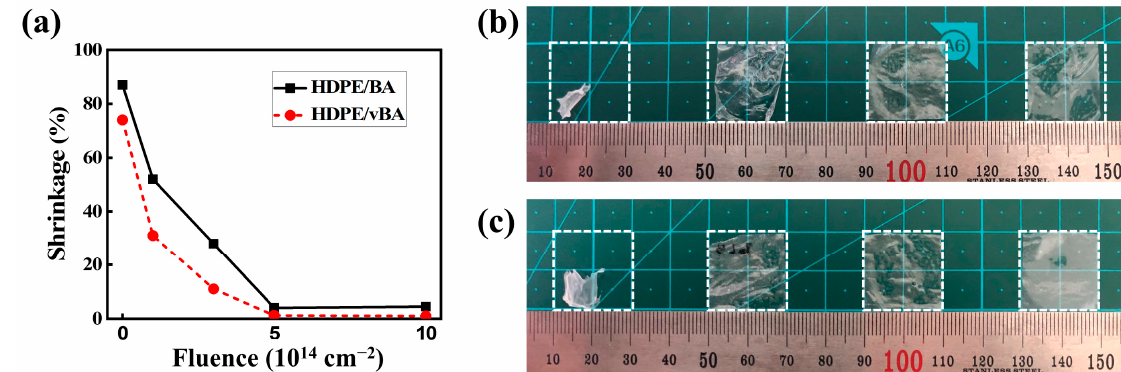
Figure 8. ( a ) Percentage of thermal shrinkage as a function of electron fluence. Photographs of BA/HDPE ( b ) and vBA/HDPE ( c ) exposed to 135 °C for 30 min. Degree of irradiation from left to right: pristine, 3 cm − 2 × 10 14 cm − 2 , 5 cm − 2 × 10 14 cm − 2 , and 1 cm − 2 × 10 15 cm − 2 .